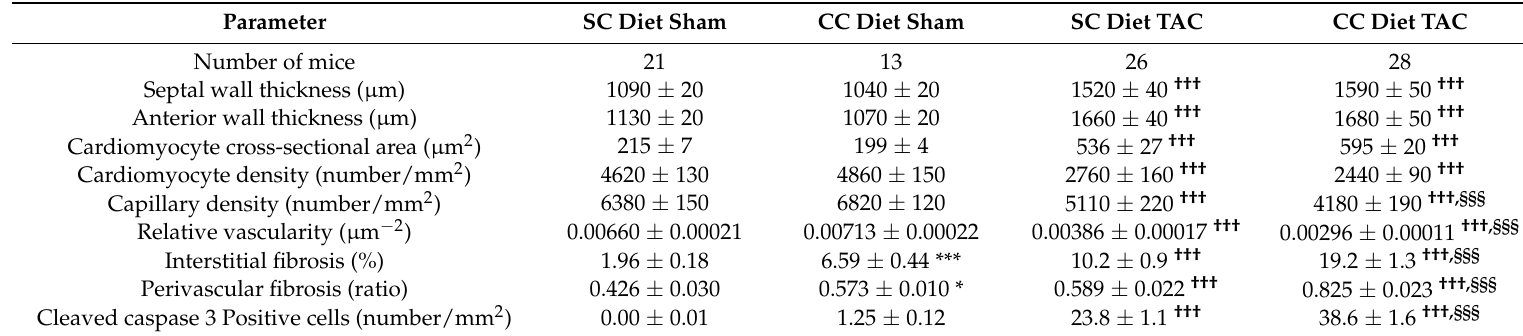
Table 3. Morphometric and histological parameters of the left ventricular myocardium eight weeks after sham operations or after TAC in C57BL/6 mice fed the SC diet or the CC